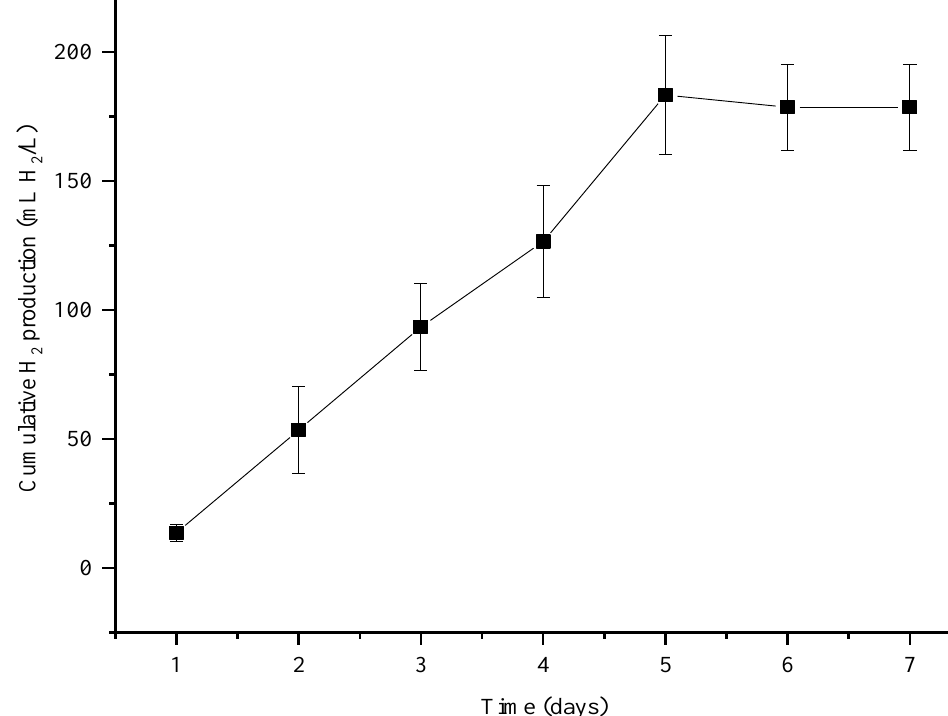
Figure 3. Cumulative hydrogen production from